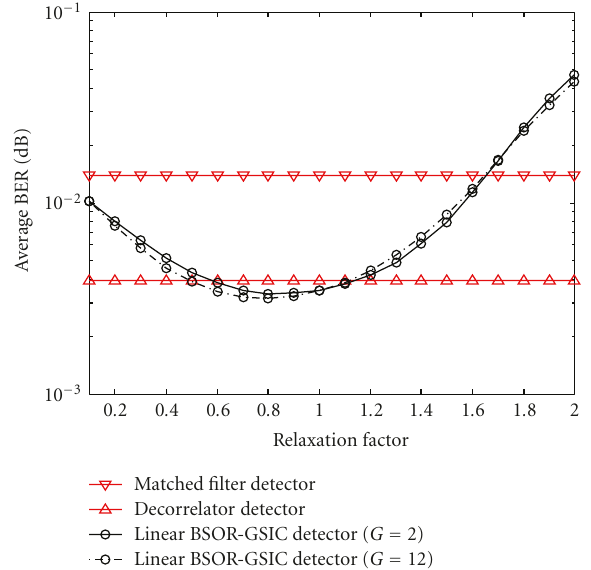
Figure 11: Average BER of the chip-level linear BSOR-GSIC detec- tor versus the relaxation factor for the case of asynchronous CDMA multipath Rayleigh fading